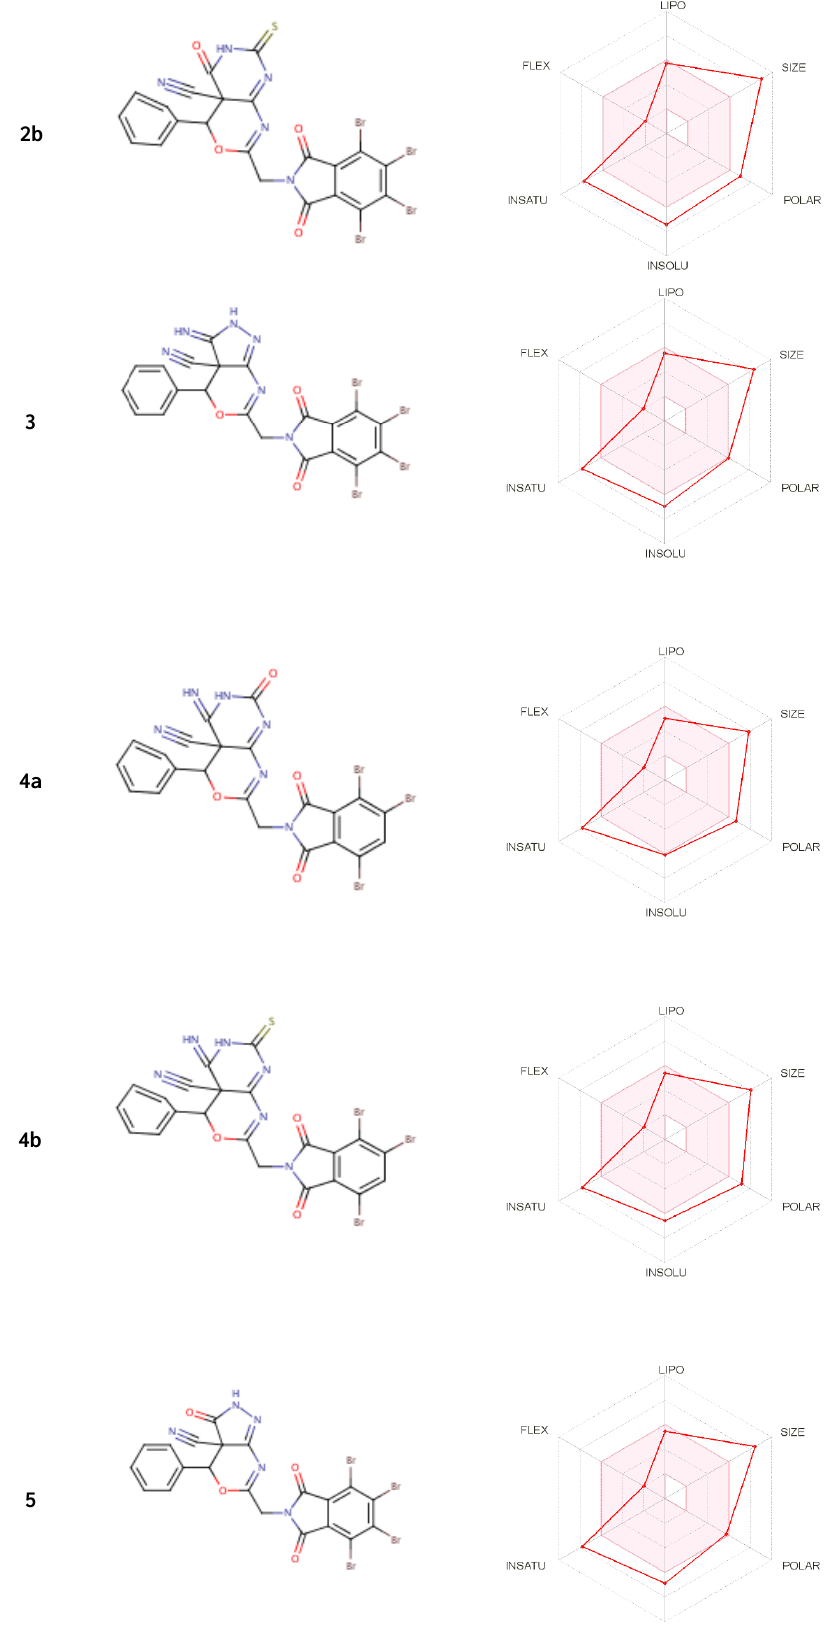
Figure 7. Inhibitors for biological systems.